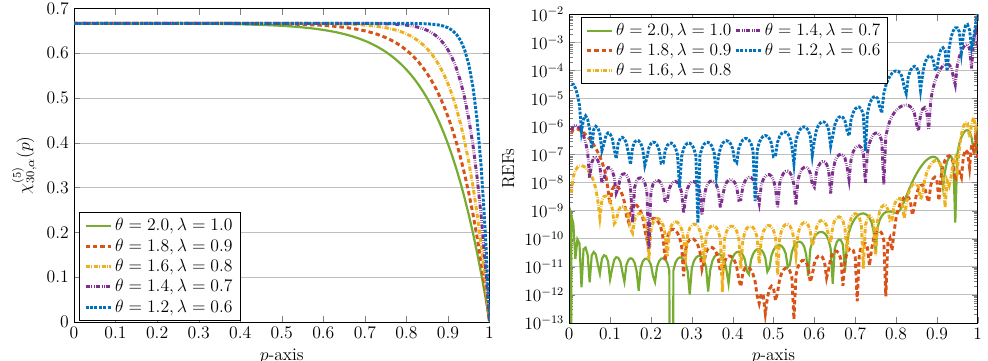
Figure 9. Graphics of numerical solutions obtained via the QLM-GSAPSK technique ( left ) and related 2 = 50, and various fractional-orders θ , λ REFs ( right ) with R = 30, α = θ , δ = 0.5, H